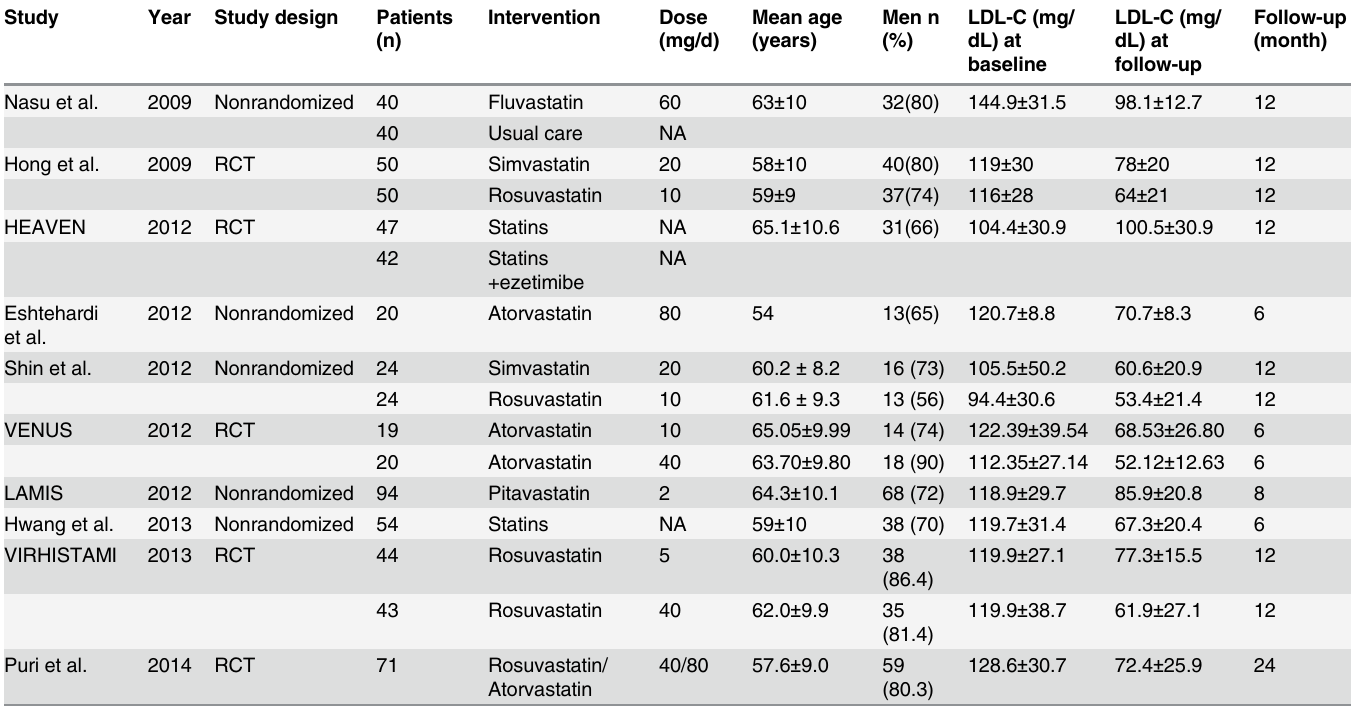
Table 1. Demographics and characteristics of the included studies.